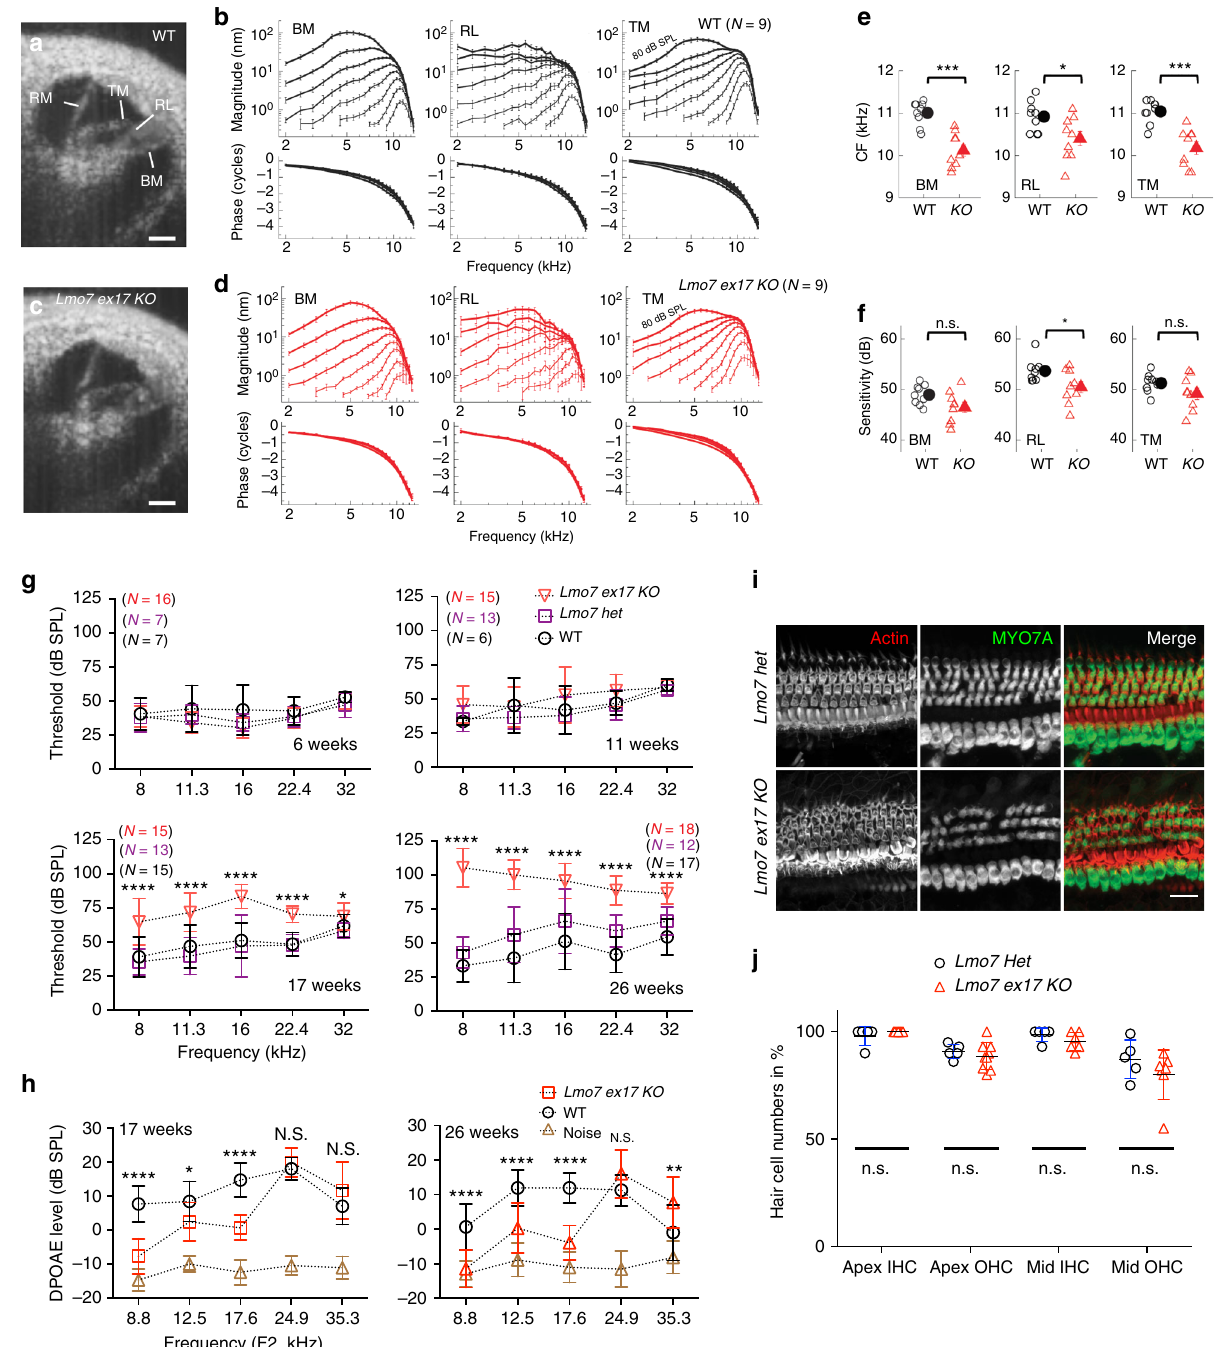
Fig. 6 Abnormal cochlear vibrations and late-onset hearing loss in Lmo7 KO mice. a , c Representative cross-sectional images of intact cochleae in live WT a and Lmo7 exon17 KO c mice obtained with VOCTV. Vibrations were measured from speci fi c points on the basilar membrane (BM), reticular lamina (RL), and tectorial membrane (TM) in the apical cochlear turn. Reissner ’ s membrane (RM) is also indicated. Scale bars, 100 µ m. b , d Average sound-evoked displacement magnitudes and phases measured from the BM, RL, and TM in WT b and Lmo7 exon17 KO d mice. Stimuli were swept from 2 – 14 kHz and varied in level from 10 – 80 dB SPL in 10 dB steps. TM displacement curve for the highest stimulus level is labeled for clarity. e Average CFs for the BM, RL, and TM were signi fi cantly lower in Lmo7 KO than in WT mice (individual data shown with open symbols). f Vibratory sensitivity at CF also tended to be lower in Lmo7 KO mice than in WT, though only signi fi cantly so for the RL. Sensitivity was de fi ned as the ratio of the response magnitude for a 20 vs. an 80 dB SPL tone at CF, after dividing both displacements by the respective stimulus pressure. Error bars indicate SEM. * p < 0.05, *** p < 0.0005, n.s. = p > 0.05, by unpaired t -test. g ABR analysis demonstrates Lmo7 exon17 KO mice exhibit late onset, progressive hearing loss. h DPOAE output differs signi fi cantly between Lmo7 exon17 KO and WT littermates at 17 and 26 weeks. At 17 weeks: N = 12 for WT, N = 13 for Lmo7 exon17 KO . At 26 weeks: N = 12 for WT, N = 14 for Lmo7 exon17 KO . Error bars indicate SD, **** p value < 0.0001, ** p value < 0.01, and * p value < 0.05 (ANOVA, Tukey post-hoc test). i , j The hair cell numbers were not signi fi cantly affected in mutant mice ( Lmo7 exon17 het control: N = 5, for Lmo7 exon17 KO: N = 6). Scale bar, 10 μ